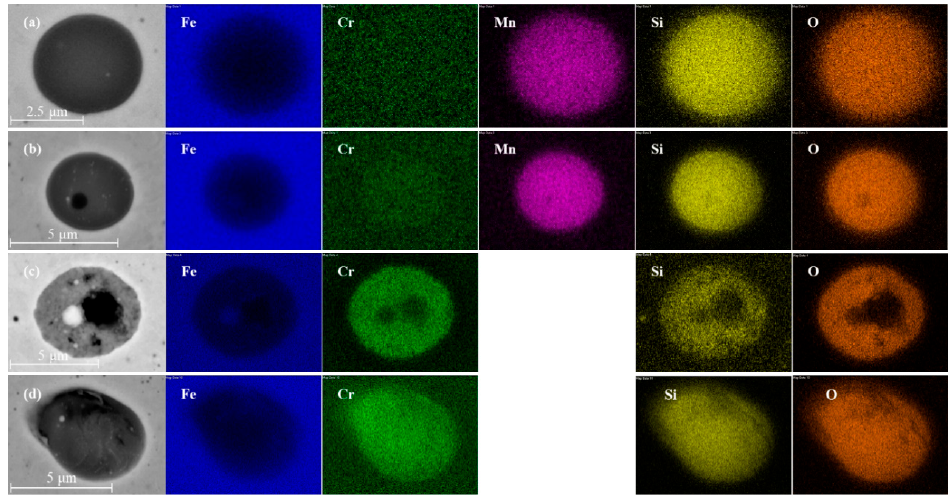
Figure 3. EDS maps of nonmetallic inclusions in ( a ) W-1, ( b ) W-2, ( c ) W-3 and ( d ) WT-1 steels. Oxides of the type MnO-SiO 2 having a maximum diameter of about 4 μ m were observed on the polished surfaces of W-1 and W-2 steels. While in W-3 and WT-1 alloys containing 3.1% wt. Cr, relatively larger (around 6 μ m) Cr-rich oxides, presumably of the type Cr 2 O 3 , were detected. In addition, Fe-rich particles were often found embedded in the Cr 2 O 3 oxides leading to more complex multi-phase inclusions, as shown in Figure 3c. Single phase SiO 2 inclusions were detected in the low- Mn and 0.82% Cr WT-2 steel, with a size up to about 2 μ m, as depicted in Figure 2f. The results are in agreement with the paper published by Shibata et.al. [30] who confirmed that Cr 2 O 3 coexists with other oxides of type MnO-SiO 2 in 5% Cr steels while only MnO-SiO 2 are observed in steels containing less than 1% Cr. Although W-4 alloy is also rich in Cr, no significant amount of inclusions was detected in the matrix owing to the post-atomisation oxygen-reduction treatment that lowers the oxygen content down to 0.159%. Higher magnification FE-SEM micrographs are collected in Figure 4 to highlight the distribution of nano-inclusions found in the investigated steels. It is readily observed that less- frequent oxides were formed in W-4 alloy compared to the other steels, confirming that the oxide inclusions are mainly dependent on the steel chemistry, in particular on the amount of oxide-former elements and oxygen content. Figure 4. High-magnification FE-SEM micrographs of the nonmetallic inclusions in ( a ) W-1, ( b ) W-2, ( c ) W-3, ( d ) W-4, ( e ) WT-1 and ( f ) WT-2 steels.